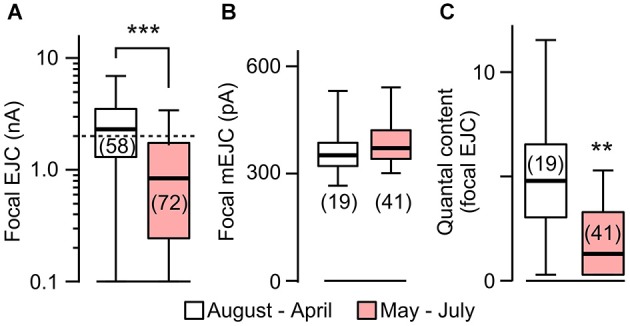
Focal EJC amplitudes affected by rearing temperature in rut. (A) Focal EJCs from the great majority of rut boutons were below 2 nA (dotted line) during the period of May to July, whereas those collected outside of this period were substantially larger. Compare to Figure 2 for constant EJC size for WT. (B) Focal mEJC amplitudes in rut did not vary with ambient temperature fluctuations. (C) Quantal content was significantly smaller at HT. Number of recording sites indicated in parenthesis. ***p < 0.001; **p < 0.01, Wilcoxon rank-sum test. (A) is reconstructed from data in Ueda and Wu (2012).